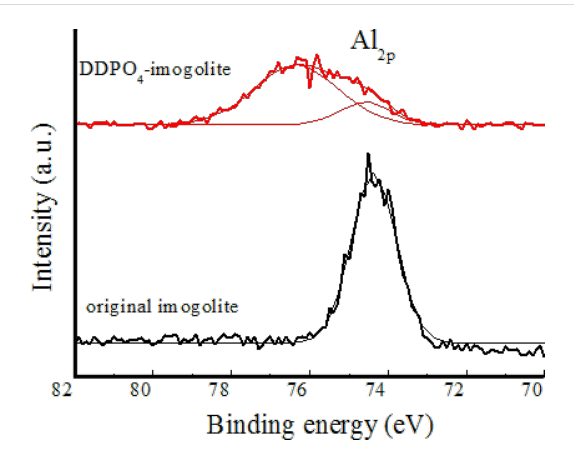
Figure 6: High-resolution XPS spectra for Al 2p of the original imogolite and DDPO 4 -imogolite. Adapted with permission from W. Ma et al., Chem. Lett. 2011, 40, 159–161 [33]. © 2011, The Chemical Society of Japan.